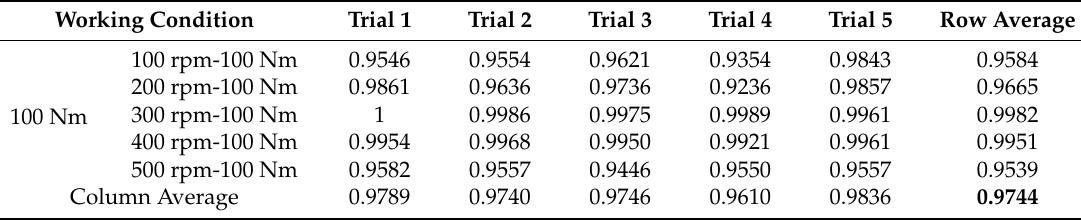
Table 5. Diagnosis accuracy of 5 trials under 5 working conditions.